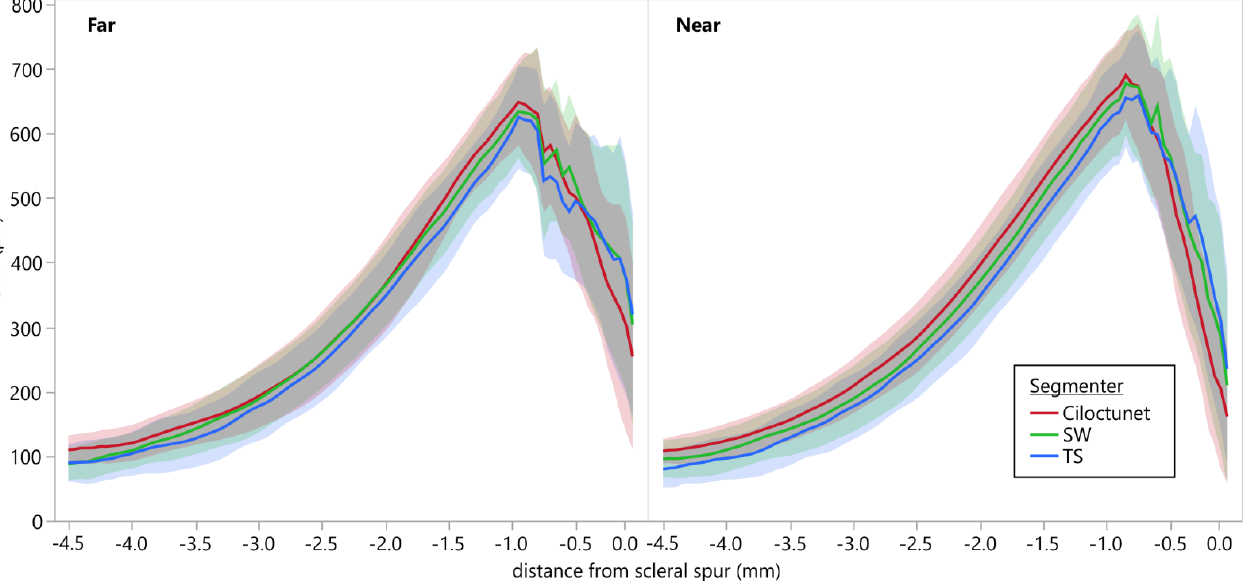
Figure 6. Averaged CMT profiles of dataset A during near and far accommodation derived from the different segmenters SW (green), TS (blue), and Ciloctunet (red). The shaded areas denote one standard deviation.